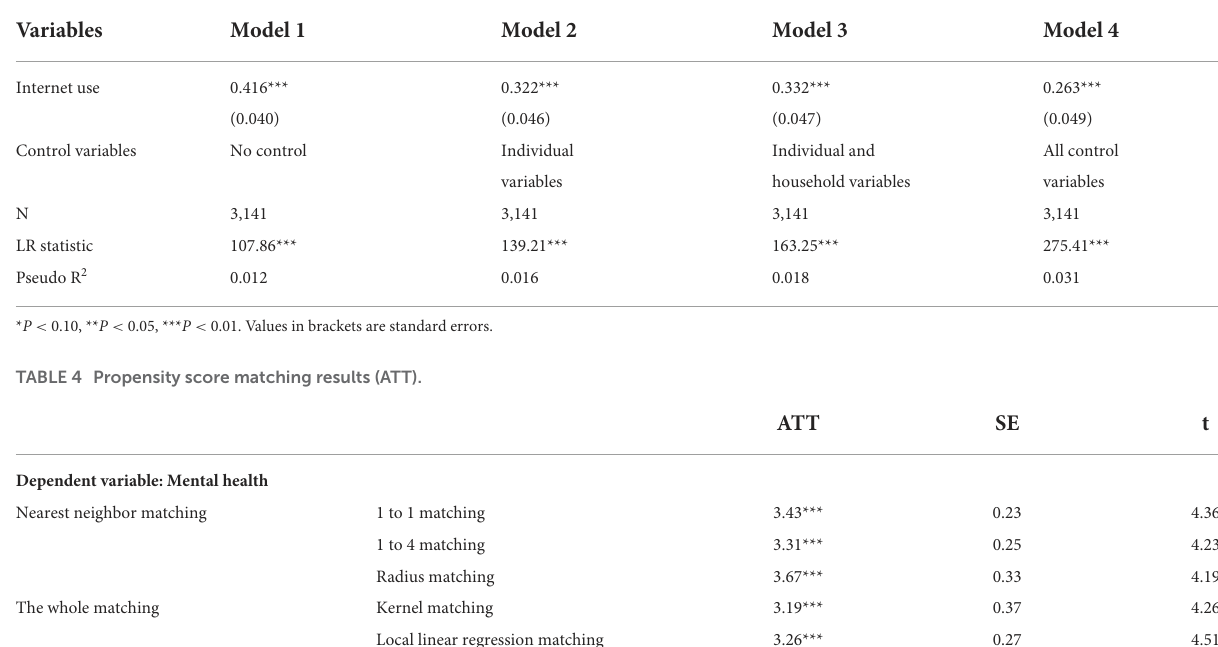
TABLE 3 Robustness test results.